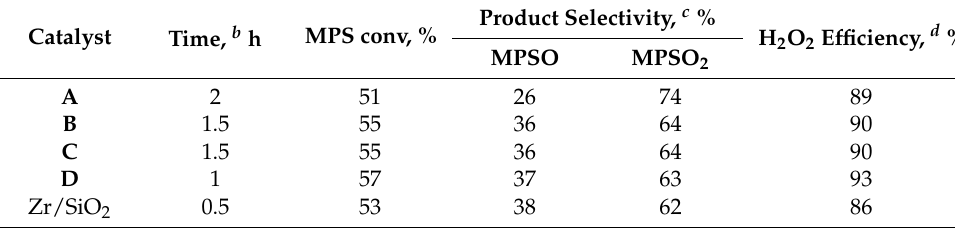
Table 5. Methyl phenyl sulfide oxidation with H 2 O 2 in the presence of Zr-Si catalysts a . Catalyst Catalyst Time, b h MPS conv,